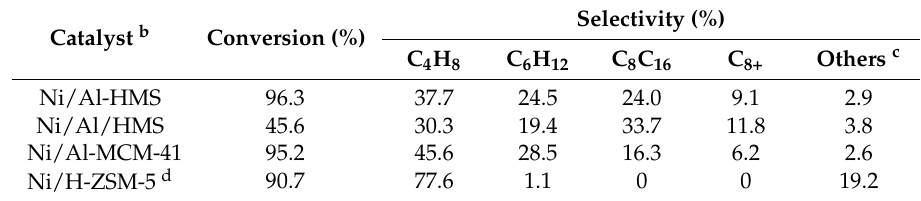
Table 1. Reaction results of ethylene oligomerization over various catalysts containing Ni and solid acid a .